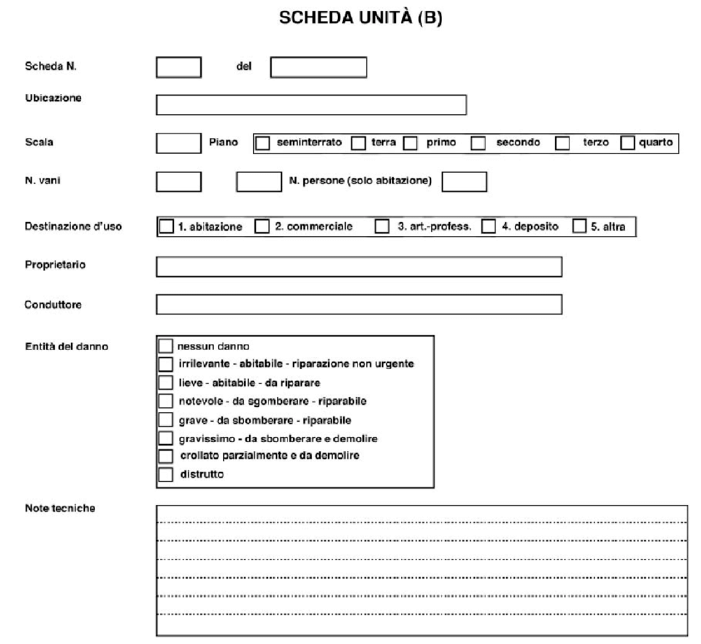
Figure 1. Example of Scheda B [31].